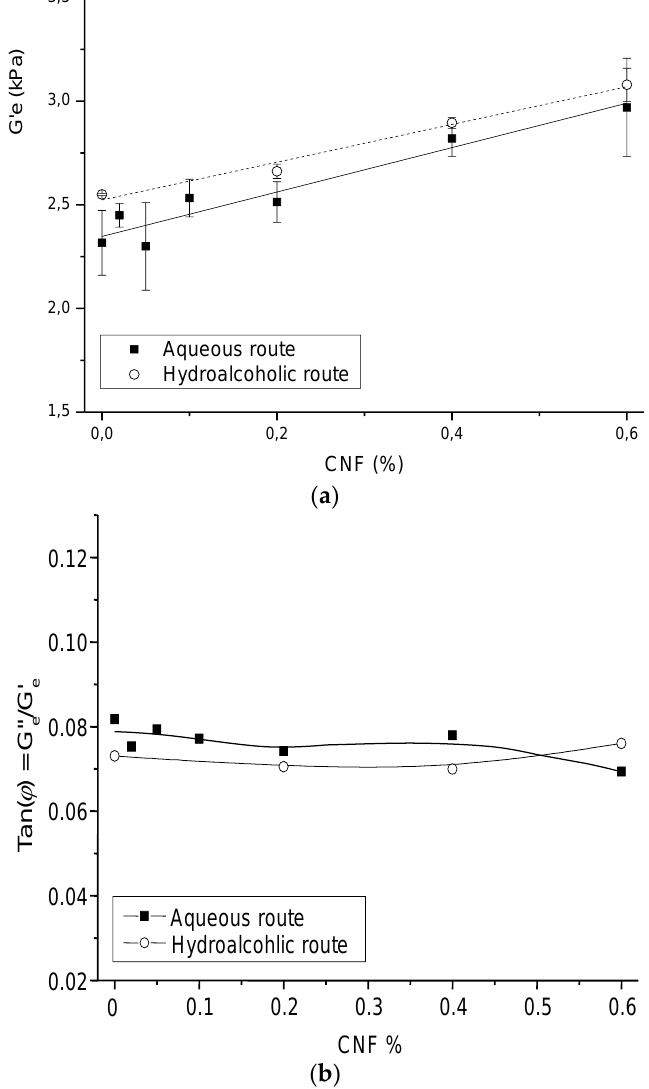
Figure 6. Evolution of the equilibrium storage modulus G’e ( a ) and dissipation ratio (Tan( φ ) = Ge’’/Ge’) ( b ) with the increase of the CNF content in the CNF/CHI hydrogel composites, obtained by the aqueous and hydroalcoholic routes.